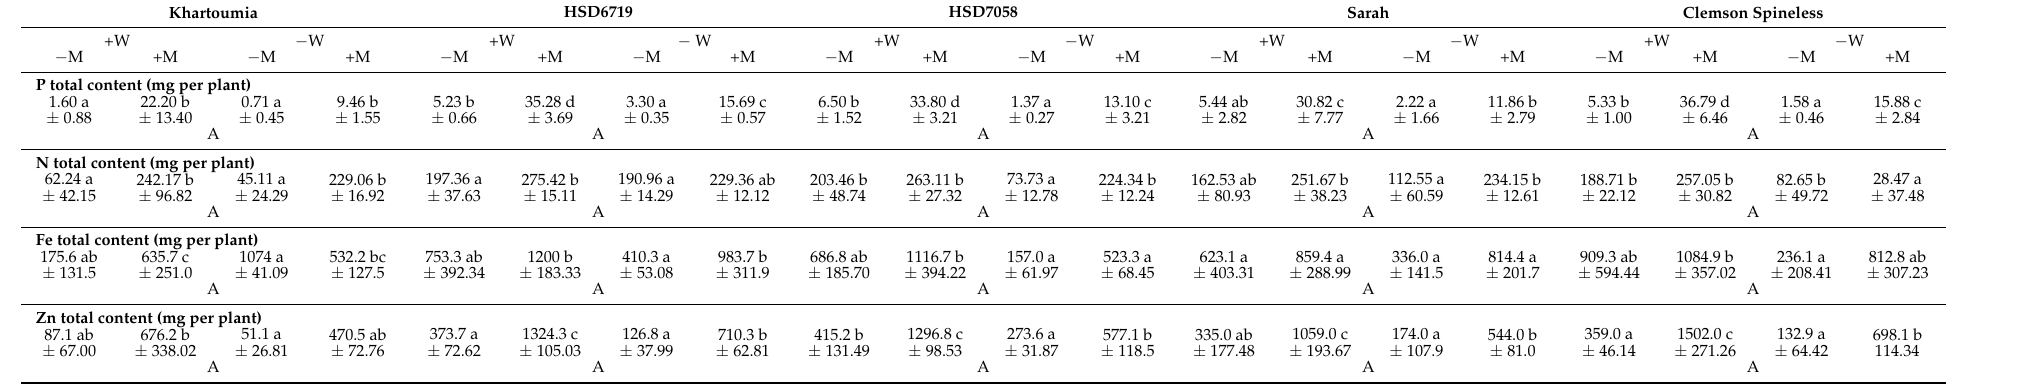
Table 3. Shoot total content of P, N, Fe and Zn of five okra cultivars. Plants were non-inoculated ( − M) or inoculated (+M) with R. irregulare . Substrate water content was either maintained at 20% (+W) or 10% w / w ( − W). For definitions of treatments and statistics, refer to the text for Figure 3. Shown are mean values ± standard deviation. Within each cultivar mean values followed by the same small letter are not significantly different (Tukey’s test, n = 4, p < 0.05). Cultivars followed by the same capital letter are not significantly different (Tukey’s test, n = 4, p <